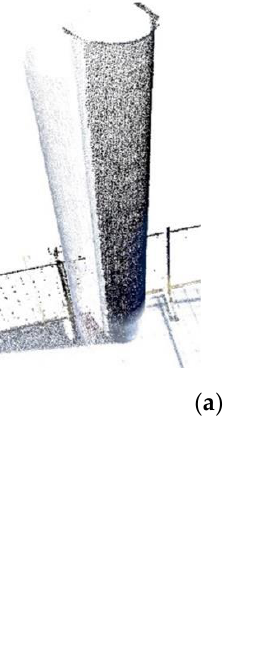
( c ) formwork is installed above the columns, and there are also scaffolding and other items